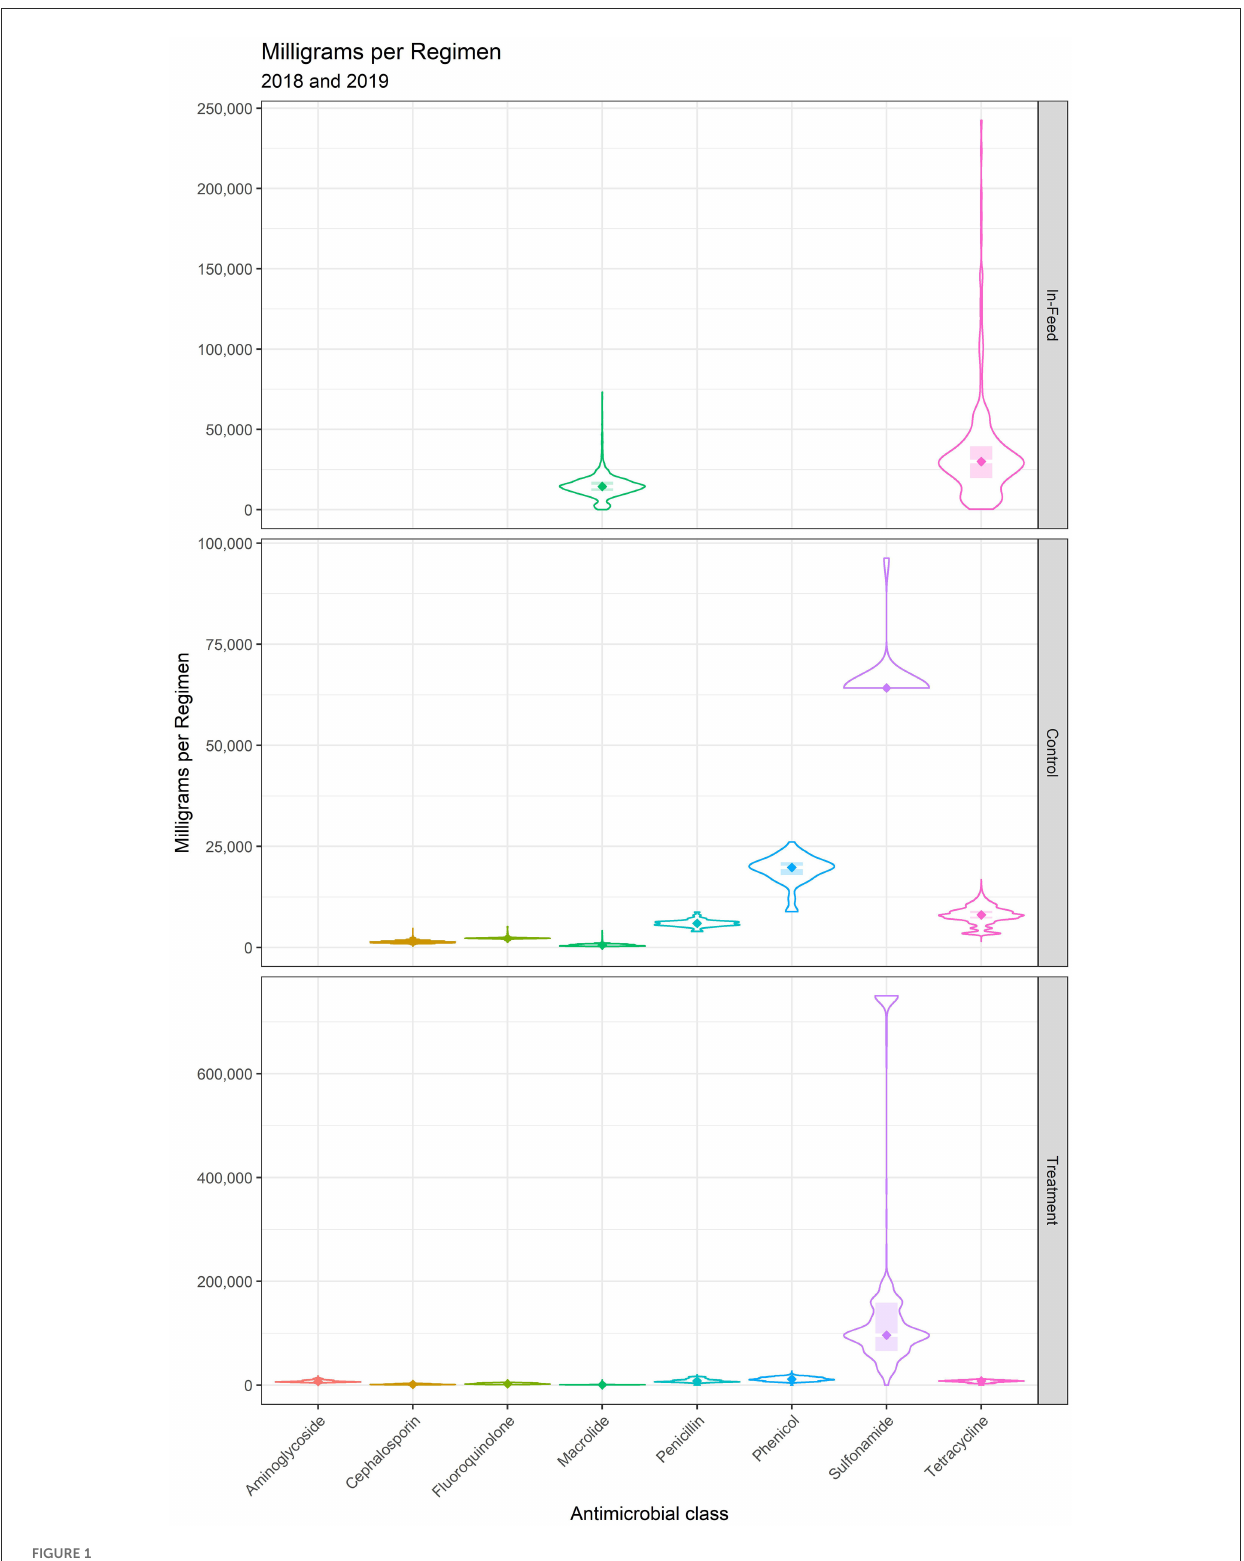
FIGURE1 Milligrams per regimen for medically important antimicrobials.